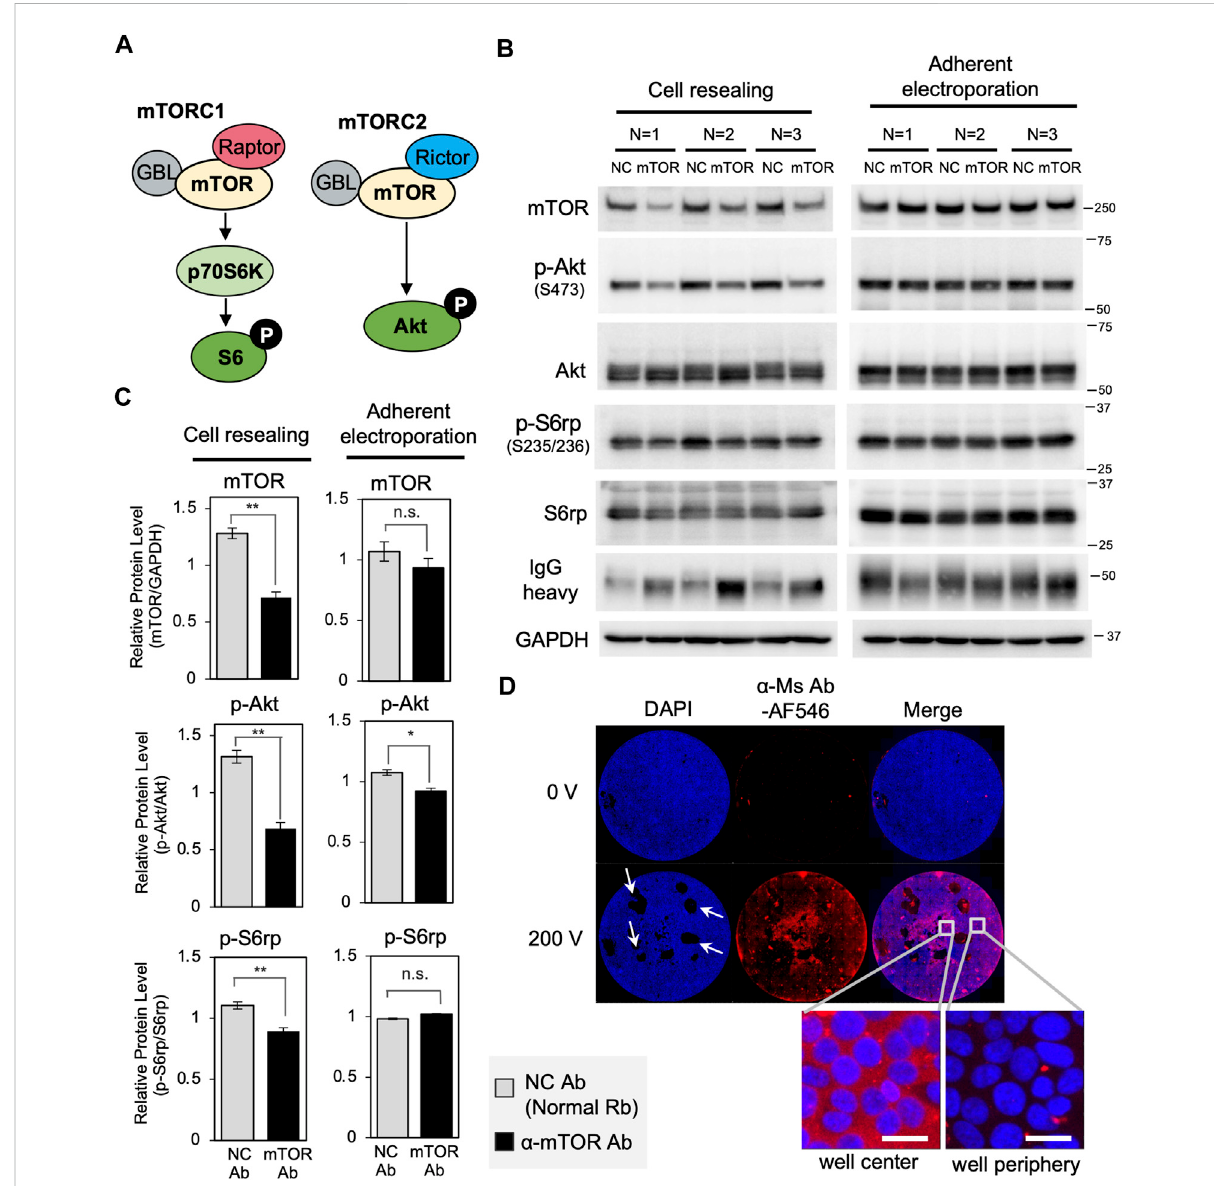
FIGURE 5 Trim-Away-mediated degradation of mTOR using the cell resealing technique or adherent electroporation. (A) Schematic of mTOR signaling. (B) The cell resealing technique or adherent electroporation were used to introduce anti-mTOR antibodies into TRIM21-overexpressed Piranha TM HEK293T cells, which were then analyzed using western blotting. Cells were introduced with 0.5 mg/ml of anti-mTOR antibody (clone 7C10, CST, Cat#2983BF) or the same amount of normal rabbit antibody as a negative control (NC), after which they were incubated for 12 h and collected for analysis. (C) Bar graph showing quanti fi cation of the bands in (B). Resealing of anti-mTOR antibody led to a 44% reduction in mTOR protein level. Downstream signaling was also inactivated: phosphorylation of Akt at Ser473 and ribosomal protein 6 (S6rp) at Ser235/236 were reduced. Degradation of mTOR or inactivation of downstream signaling was not detected in the adherent electroporation-mediated experiment. Data are expressedasmean±SEM( n =3).*P < 0.05,**P < 0.01,ns:notsigni fi cant.Rb:rabbit,Ab:antibody. (D) MicroscopyimagesofPiranha TM HEK293Tcells with Alexa Fluor 546-labeled anti-mouse goat IgG ( α -Ms Ab-AF546) introduced into the cells using adherent electroporation. Whole-well views showthatonlythecellsnearthecenterofthewellthat werelocatedbetweentheelectrodeswerewellelectroporated,whereasthemajorityofcells at the periphery were not electroporated. Scale bar: 20 μ m. Ms: